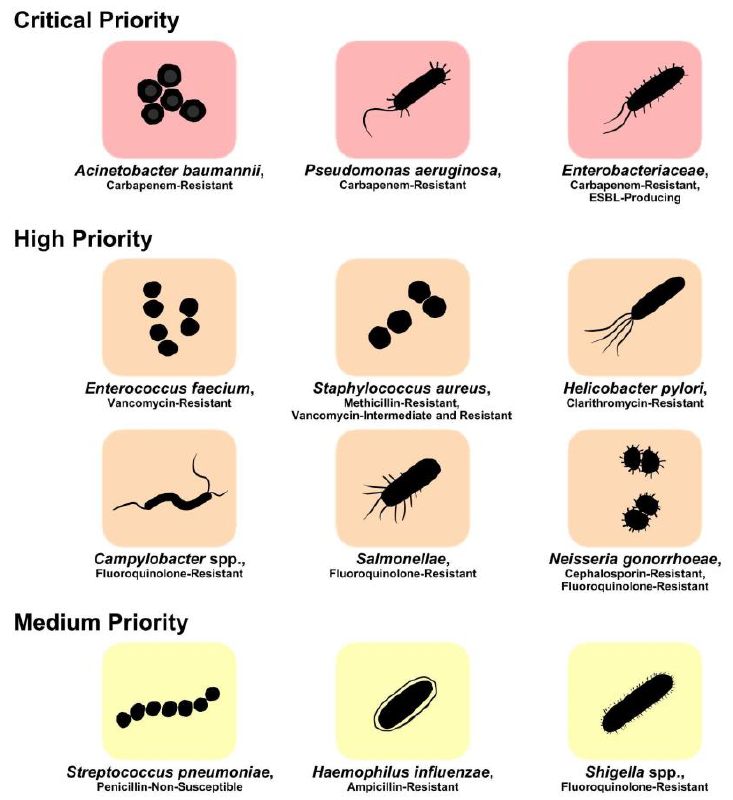
Figure 1. WHO global priority list of antibiotic-resistant bacteria to guide research, discovery, and development of new antibiotics, adapted with permission from WHO [13]. Helicobacter pylori is listed as a high-priority organism.